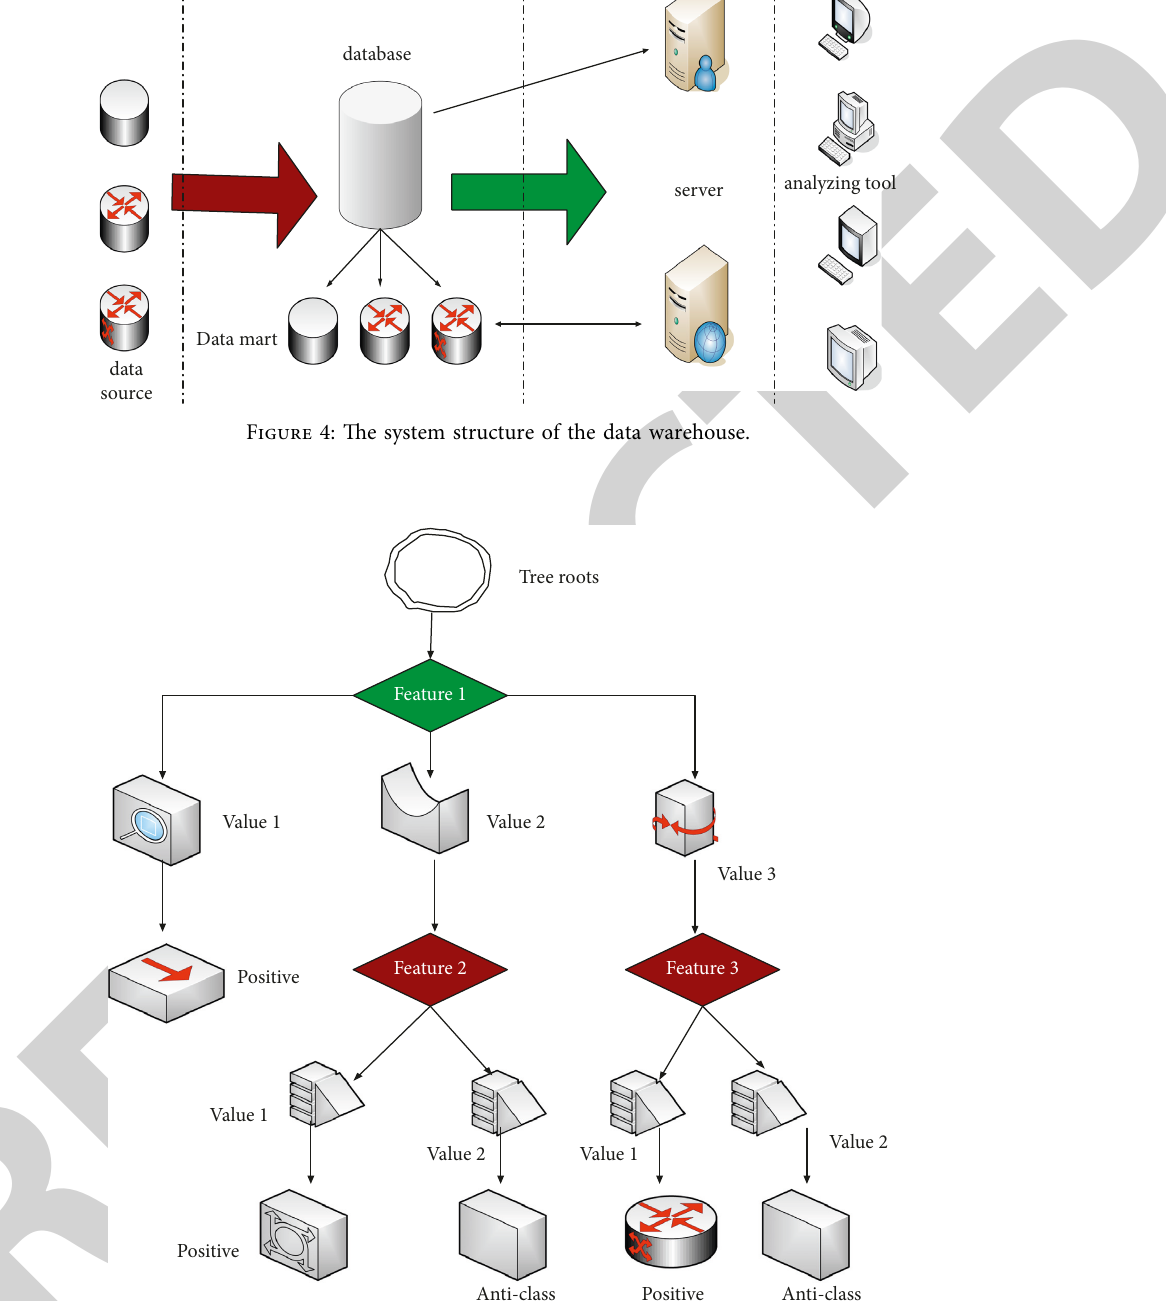
Figure 5: Decision tree structure.